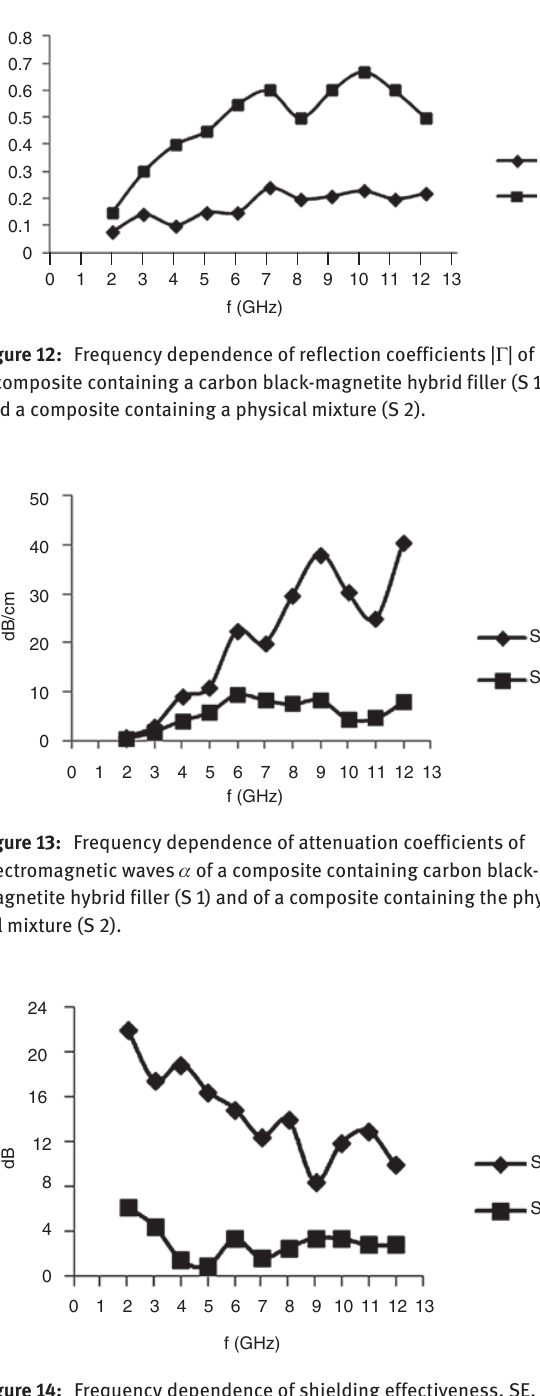
Figure 14: Frequency dependence of shielding effectiveness, SE, of a composite containing carbon black-magnetite hybrid filler (S 1) and a composite containing their physical mixture (S